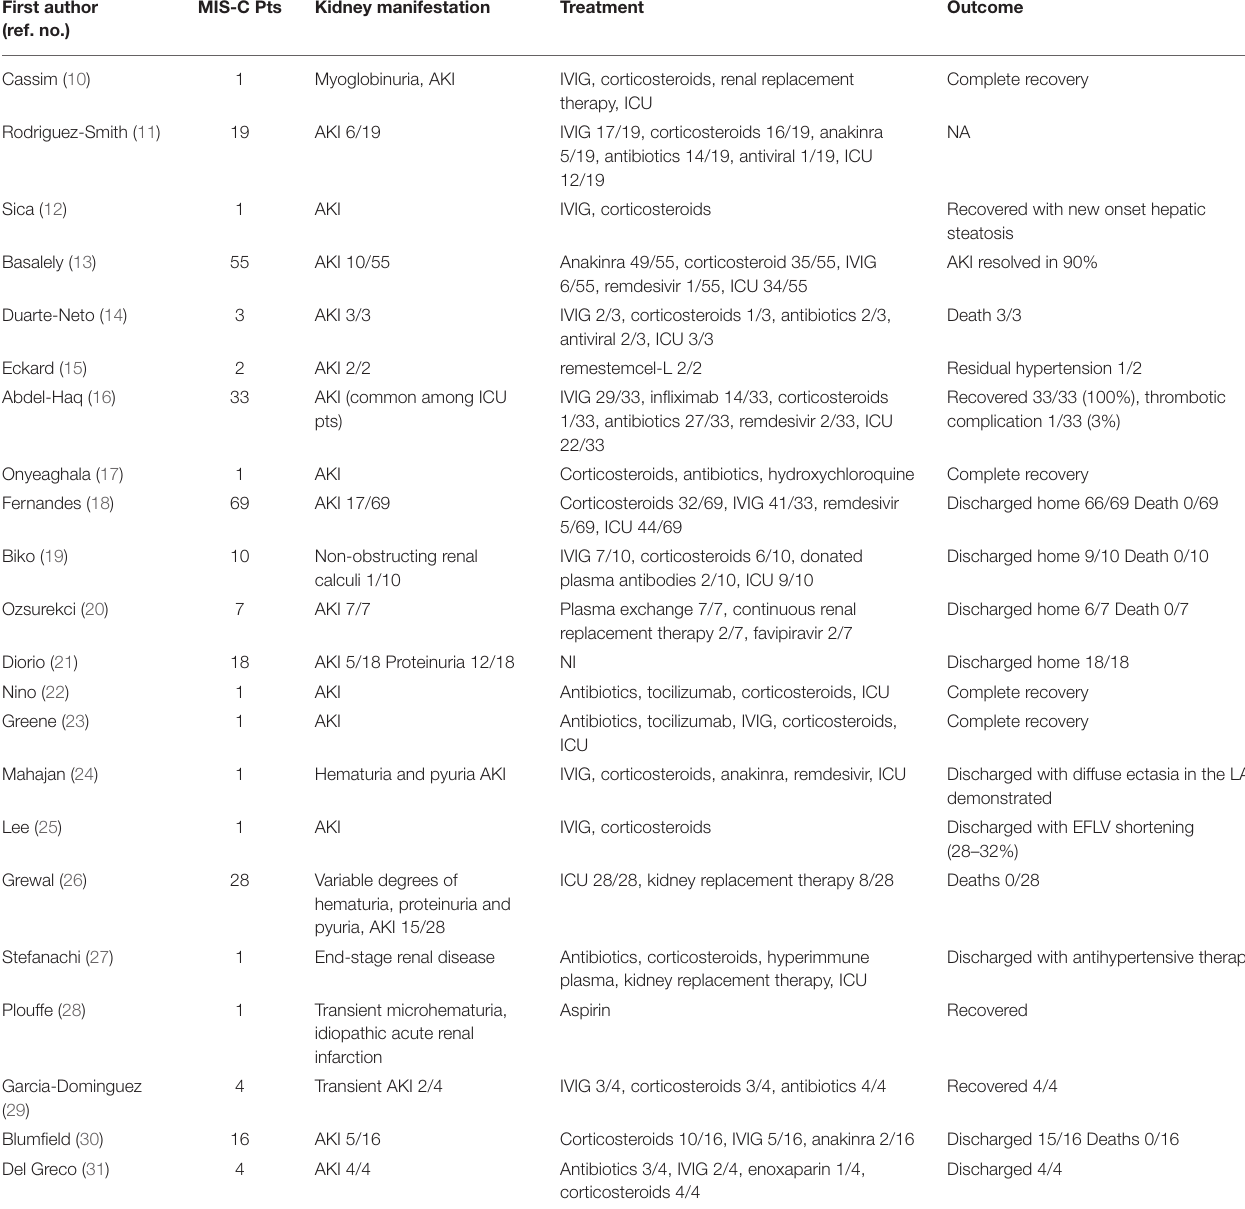
TABLE 1 | Clinical characteristics, treatment modalities, and outcome of MIS-C patients with renal impairment. First author (ref.